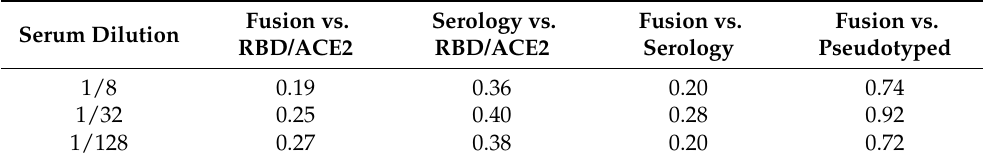
Table 2. Coefficient of correlation (R 2 ) obtained from different comparisons between the RBD/ACE2 competitive ELISA, the fusion assay and a conventional serology using bio-chemiluminescence. In total, 47 sera were tested by the three methods and correlations coefficients were calculated. The 1/512 dilution was removed because of a lack of sensitivity of detection with this dilution. Fusion vs. Serology vs. Fusion vs. Fusion vs. Serum Dilution RBD/ACE2 RBD/ACE2 Serology